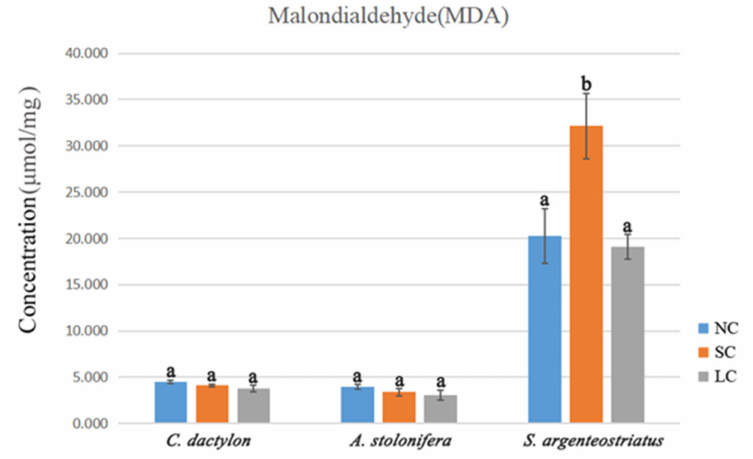
Figure 7. Graph of malondialdehyde concentrations. Note: Different normal letters indicate signifi- cant differences among treatments ( p < 0.05).